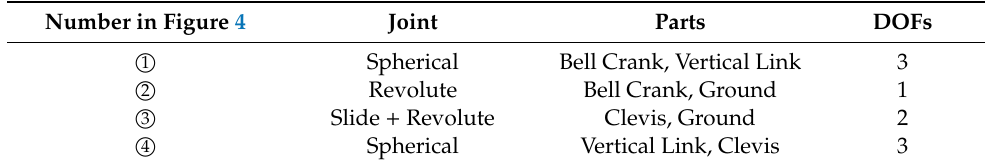
Table 3. Definitions of joints in ADAMS model.